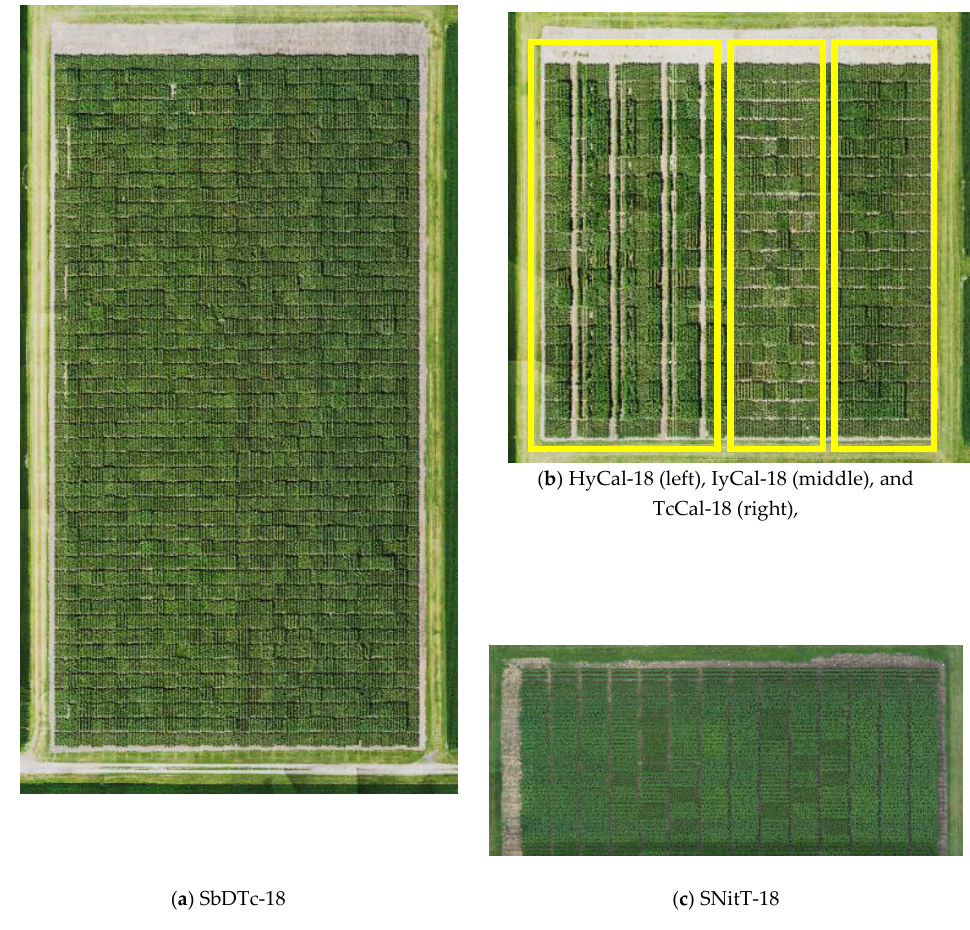
Figure A2. RGB images of the field trials in 2018.